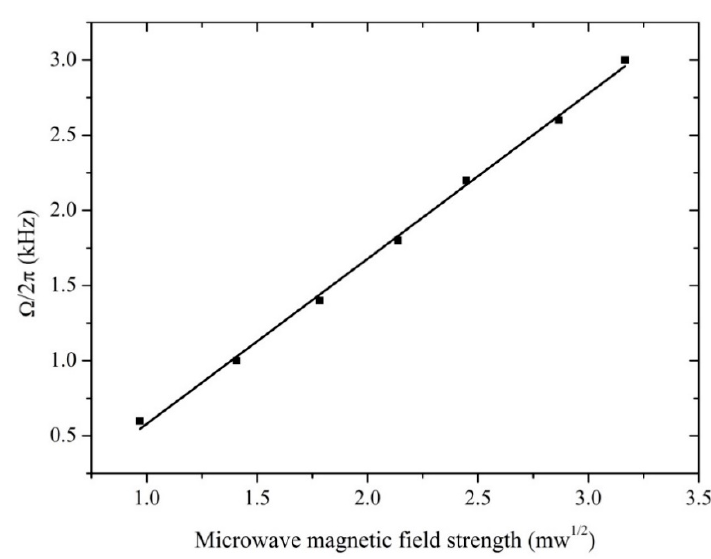
Figure 4. Dependence of Rabi frequency on microwave magnetic field strength. Plots were obtained from Figure 3. Horizontal axis values of plots were abscissa values of the atomic candle signal peak at different microwave phase-modulating frequencies of ω m /2 π (300 Hz, 500 Hz, 700 Hz, 900 Hz, 1.1 kHz, 1.3 kHz, and 1.5 kHz). Vertical axis values of the plots were the corresponding Rabi frequencies of 2( ω m /2 π ) (600 Hz, 1 kHz, 1.4 kHz, 1.8 kHz, 2.2 kHz, 2.6 kHz, and 3.0 kHz). The straight line was fitted by the measured plots. The Rabi frequency is proportional to the microwave field strength, which is expected from Equation (6). The diameter of the laser spot was 3 mm and the laser intensity was 85 µ W/cm 2 . The phase modulation index of θ was set 2.3 rad.